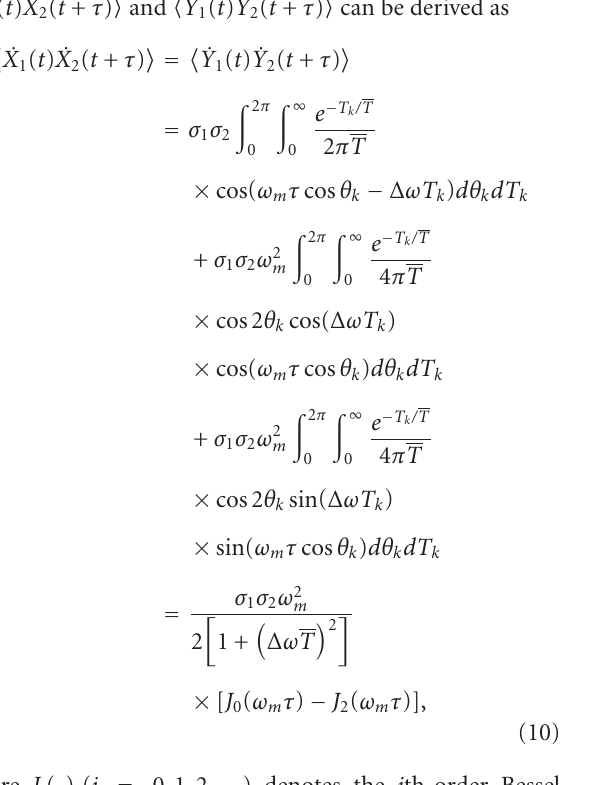
Figure 3: Cross-correlation function of in-phase and quadrature processes of the cascaded fading